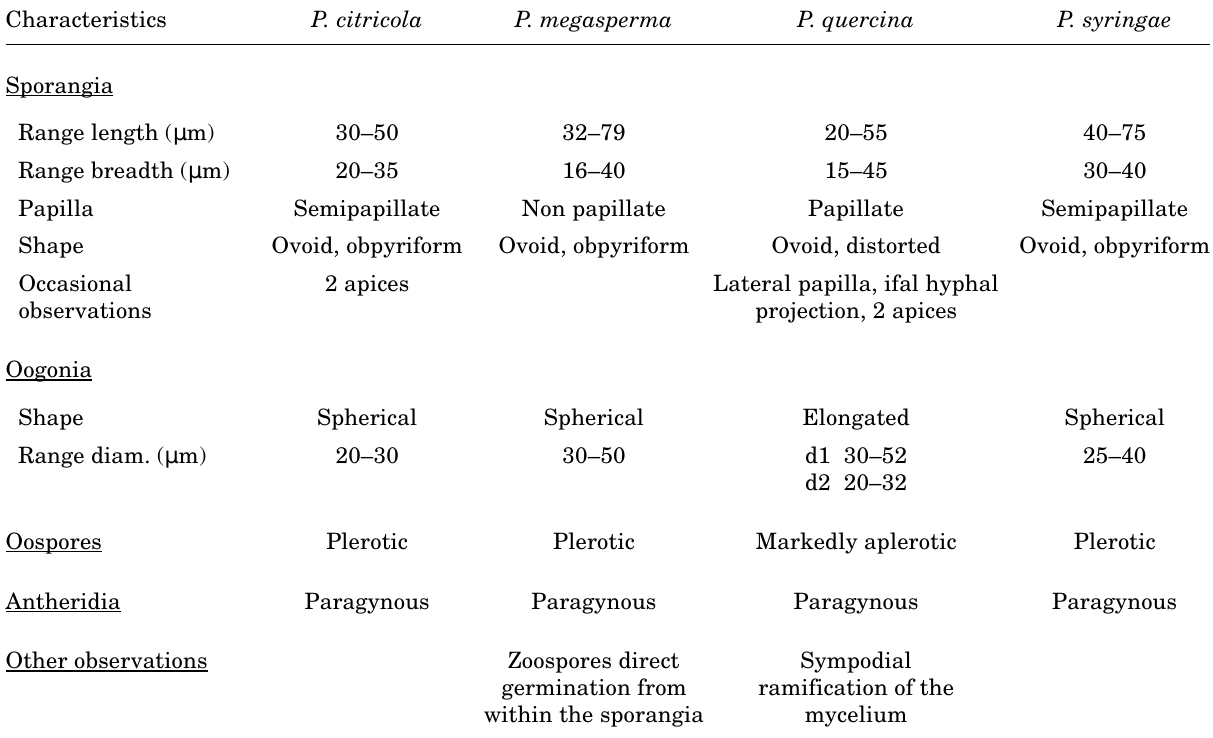
Table 2. Main morphological characteristics of four Phytophthora species collected from Quercus cerris and Quercus robur forests soils in northern and central